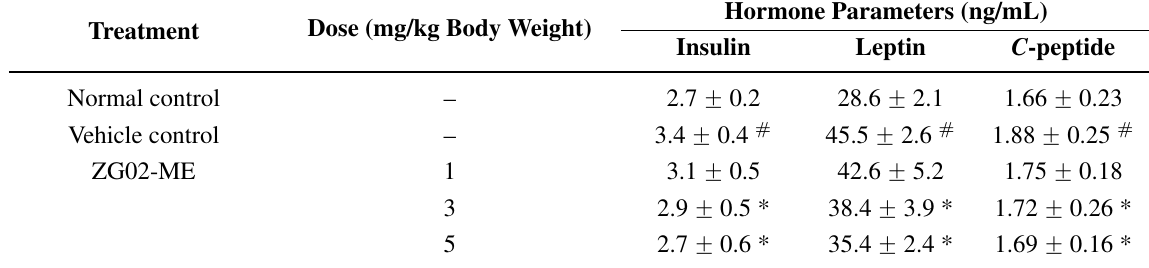
Table 3. Effect of ZG02-ME on serum insulin, leptin, and C -peptide levels in diabetic-obese ( db / db ) mice.